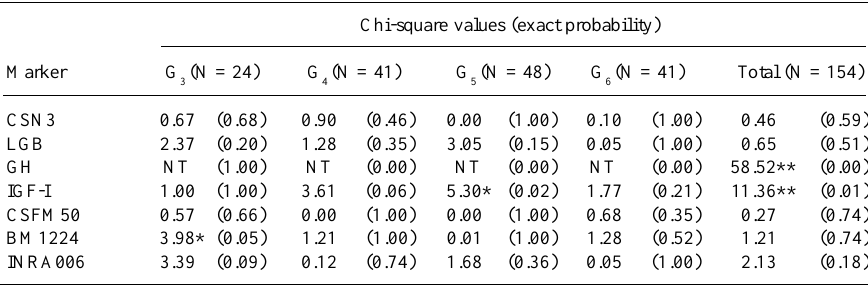
Table III - Hardy-Weinberg equilibrium tests within generations and the total Canchim sample for the seven markers analyzed. Chi-square values (exact